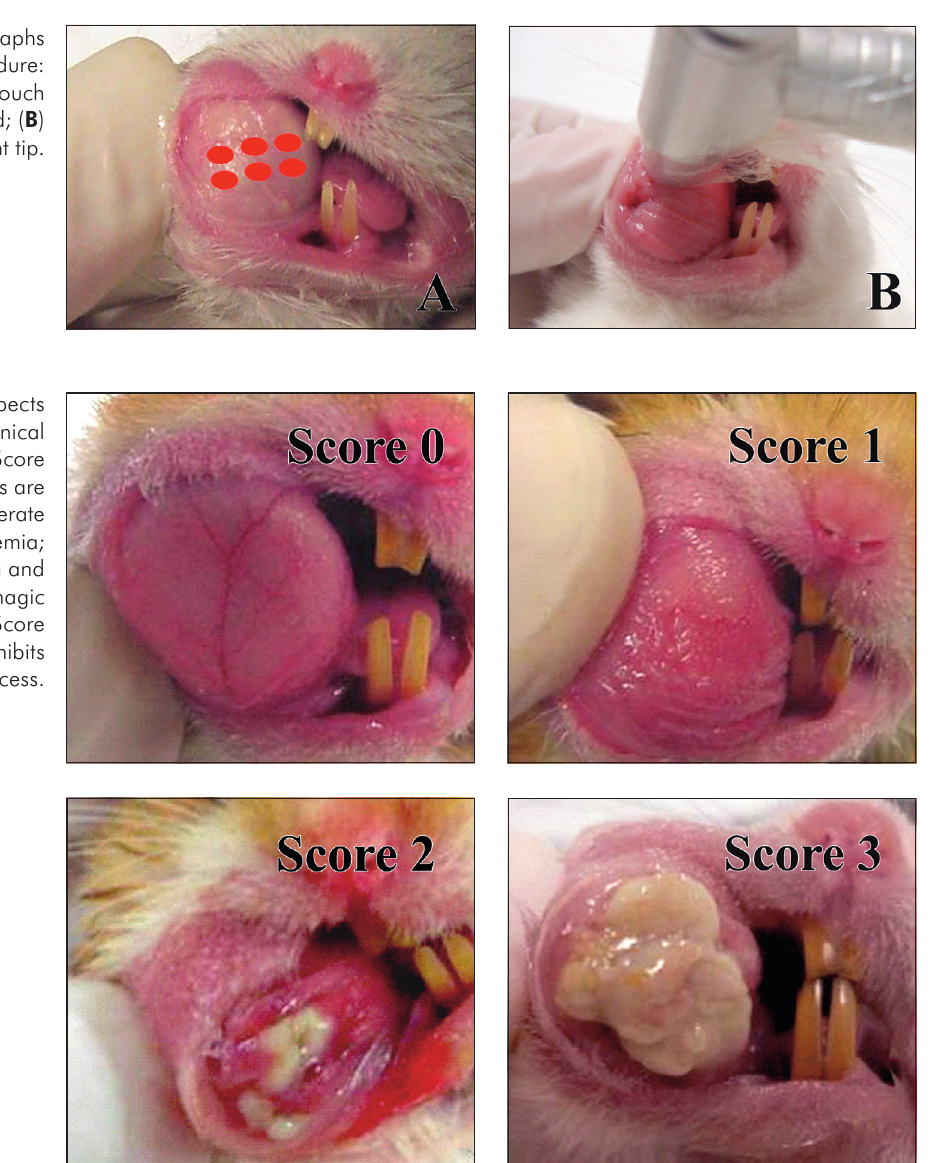
Figure 1 - Illustrative photographs showing the irradiation procedure: mucosa was irradiated; ( B ) positioning of laser equipment tip.